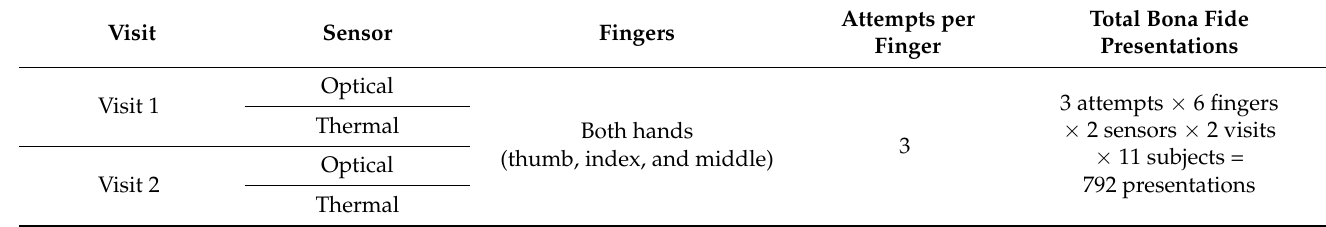
Table 5. Summary of the bona fide visits per scenario.